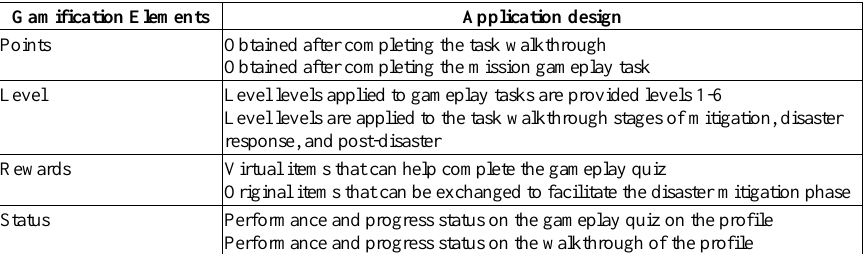
Table 5. Result of gamification design